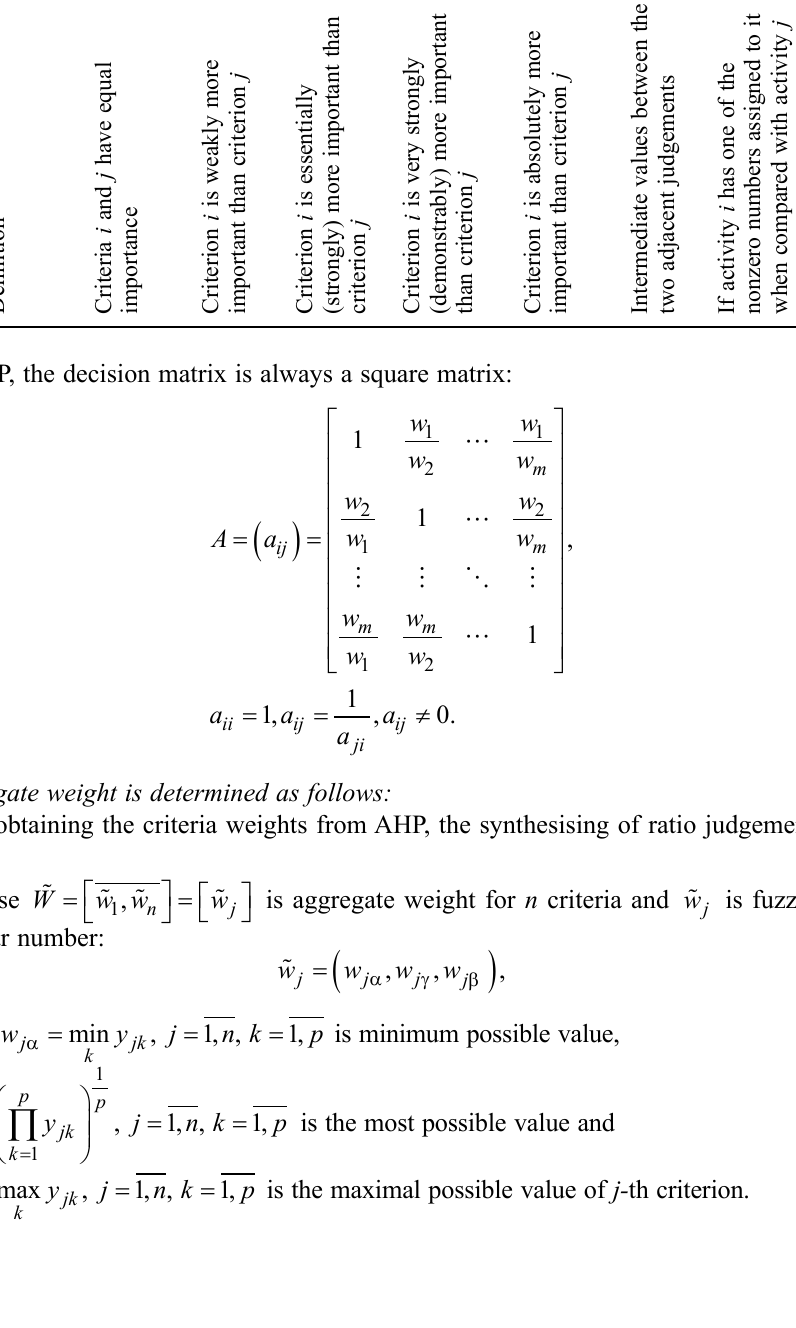
Table 1 . The nine-point scale of pair wise comparison (according to Saaty 1980) Intensity of